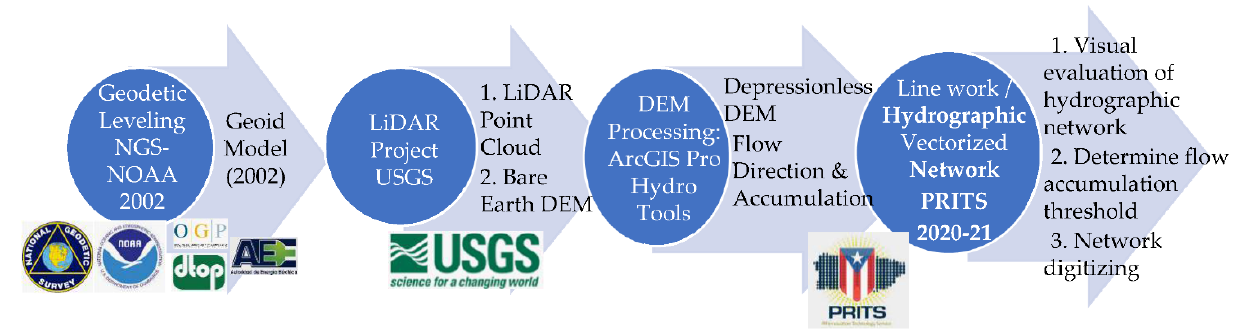
Figure 2. Process to generate the digital elevation model and the densified hydrographic network.